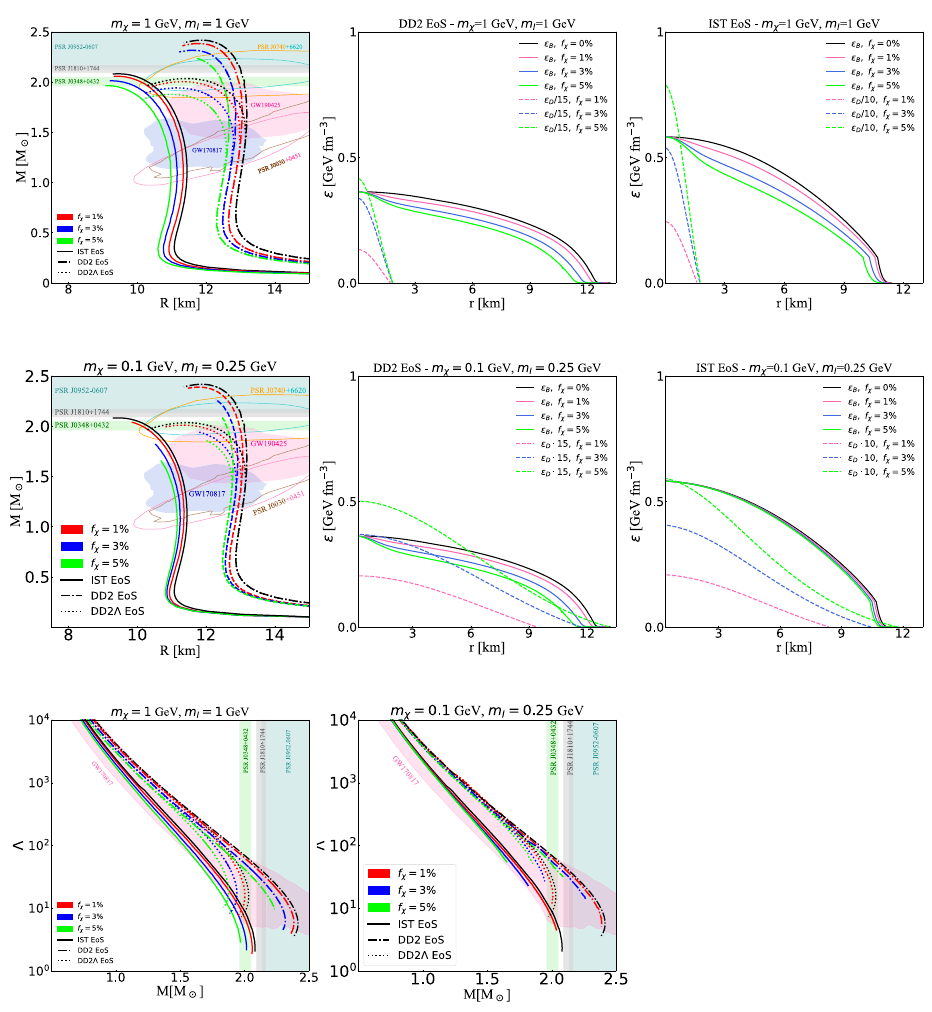
Figure 2. Upper row: Total gravitational mass of the DM-admixed NSs as a function of its visible radius R (left panel). Black curves correspond to pure BM stars described by the IST EoS, DD2 EoS and DD2 EoS with hyperons (dubbed as DD2 Λ ). Red, blue, and green colours depict relative DM fractions equal to 1%, 3%, and 5%, correspondingly. Green, gray, and teal bands represent 1 σ constraints on the mass of, respectively, PSR J0348 + 0432 [11], PSR J1810 + 1744 [13], and PSR J0952-0607 [14]. Pink and beige contours show the NICER measurements of PSR J0030 + 0451 [26, 27], while orange and blue contours depict the PSR J0740 + 6620 measurements [28, 29]. LIGO-Virgo observations of GW170817 [30] and GW190425 [31] binary NS mergers are shown in blue and magenta. Energy density profiles for BM (solid curves) and DM (dotted curves) components are shown for the DD2 EoS (middle panel) and IST EoS (right panel). While the solid black curve depicts the profile for a 1.4 M (cid:4) NS, the other profiles were obtained considering the same central baryonic chemical potential as of the pure baryonic star and adding DM to the configurations. Both panels were obtained for m χ = 1 GeV, m I = 1 GeV. Middle row: The same as on the upper row, but for m χ = 0.1 GeV, m I = 0.25 GeV. Lower row: Tidal deformability as a function of total gravitational mass calculated for pure BM stars (black curves) and DM-admixed NSs for m χ = 1 GeV, m I = 1 GeV (left panel) and m χ = 0.1 GeV, m I = 0.25 GeV (middle panel) with relative DM fractions 1%, 3%, and 5%, in red, blue, and green, correspondingly. The magenta area visualizes the constraints obtained from GW170817 [30]. Other curves and bands follow the notation of the top left